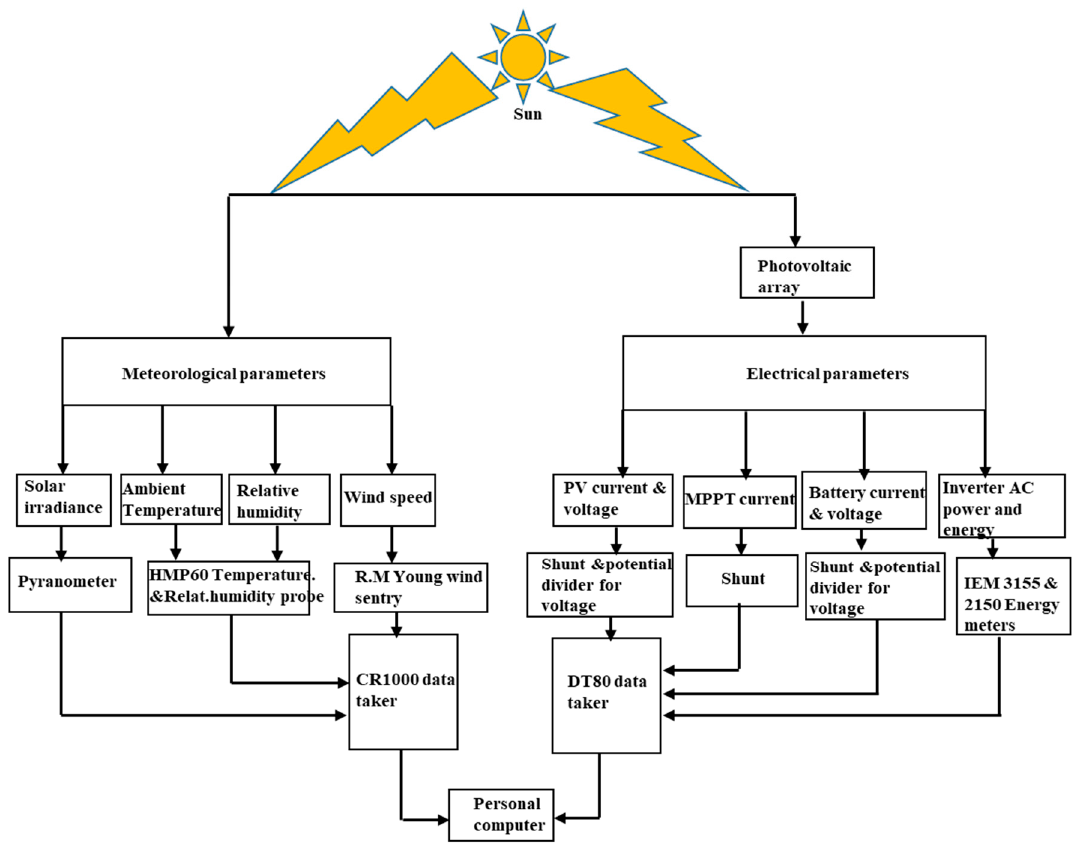
Figure 4. Schematic view of the meteorological and electrical parameters with sensors for the DAS.